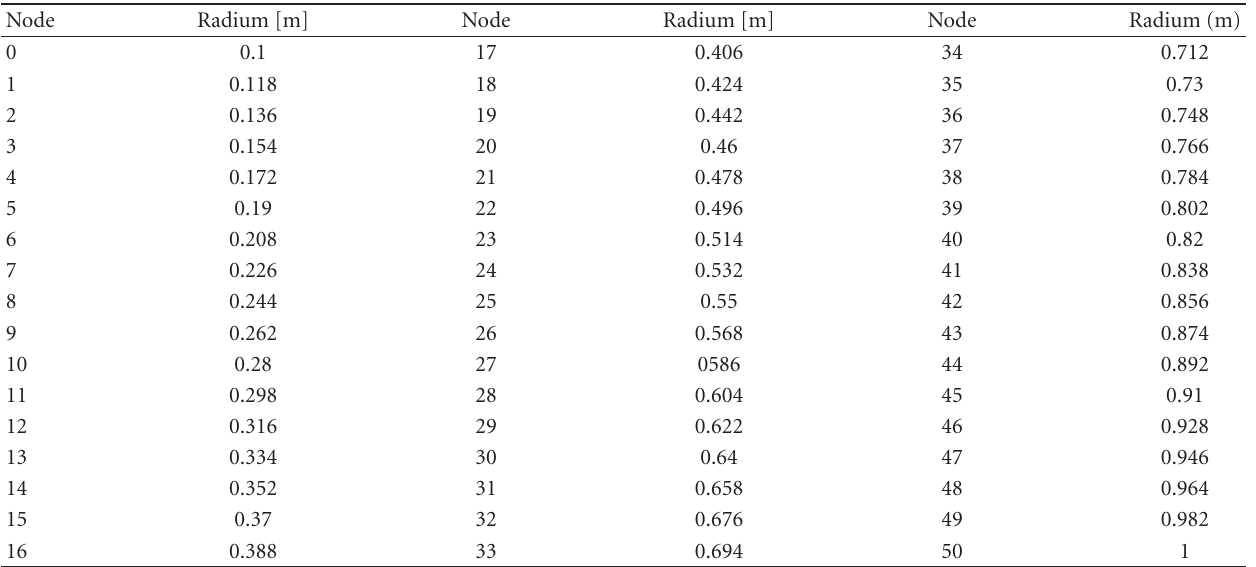
Table 1: Mesh distribution.